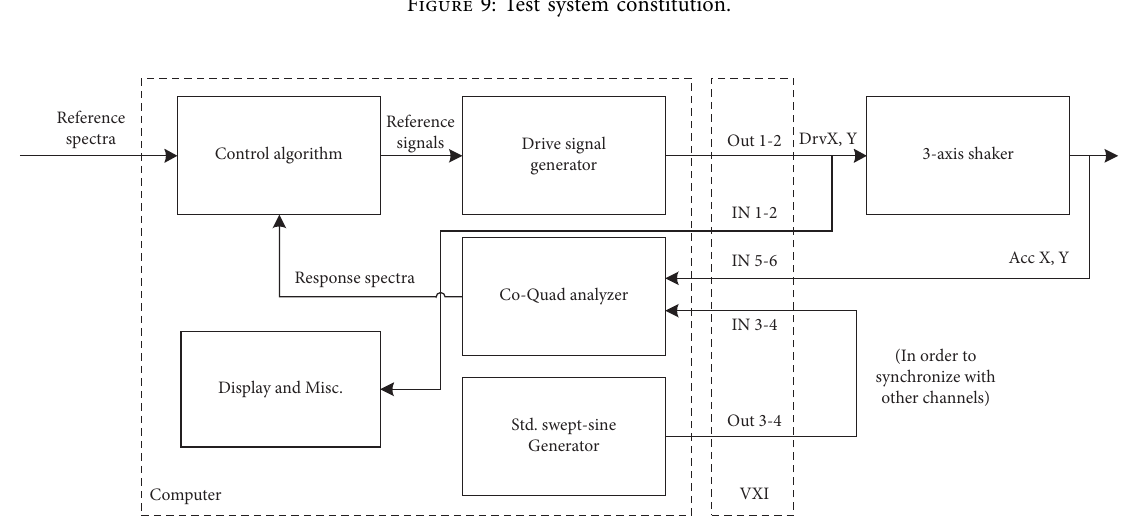
Figure 10: Block diagram for the test